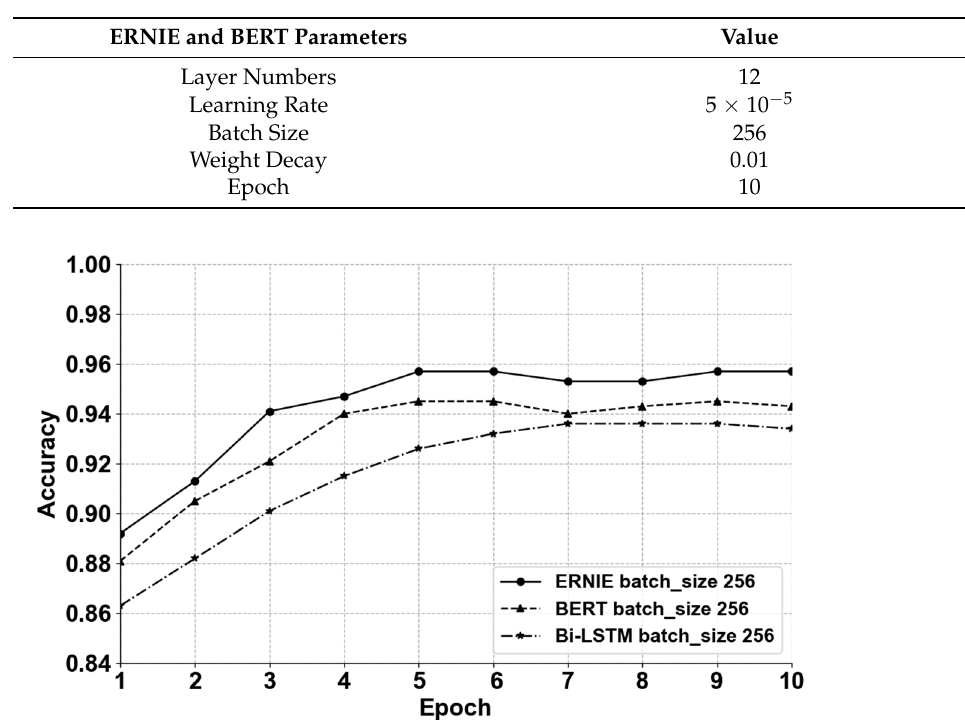
Figure 6. Accuracy of different algorithms. Table 3. Parameters of FastText model